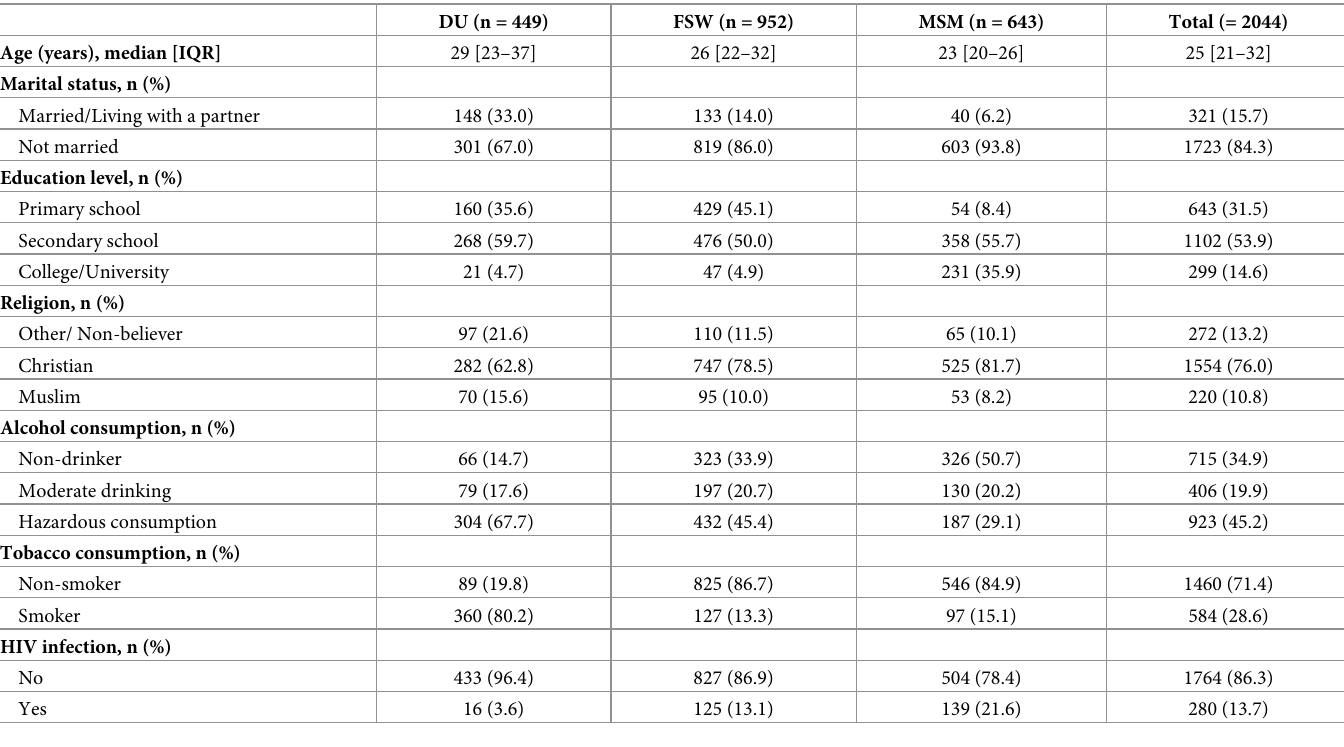
Table 1. Sociodemographic and clinical characteristics of key populations, Togo